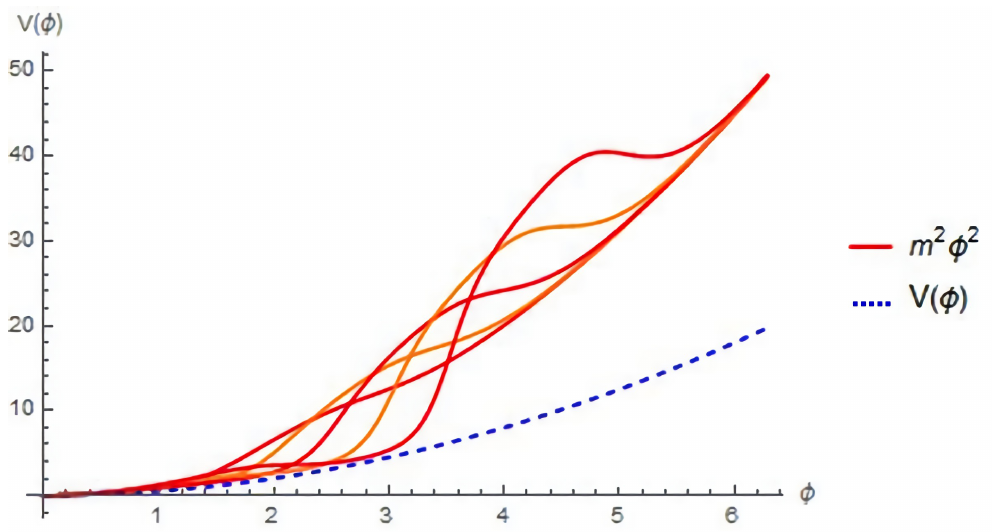
Figure 1. The potential computed with pseudocycle corrections (continuous curves) and without (dotted